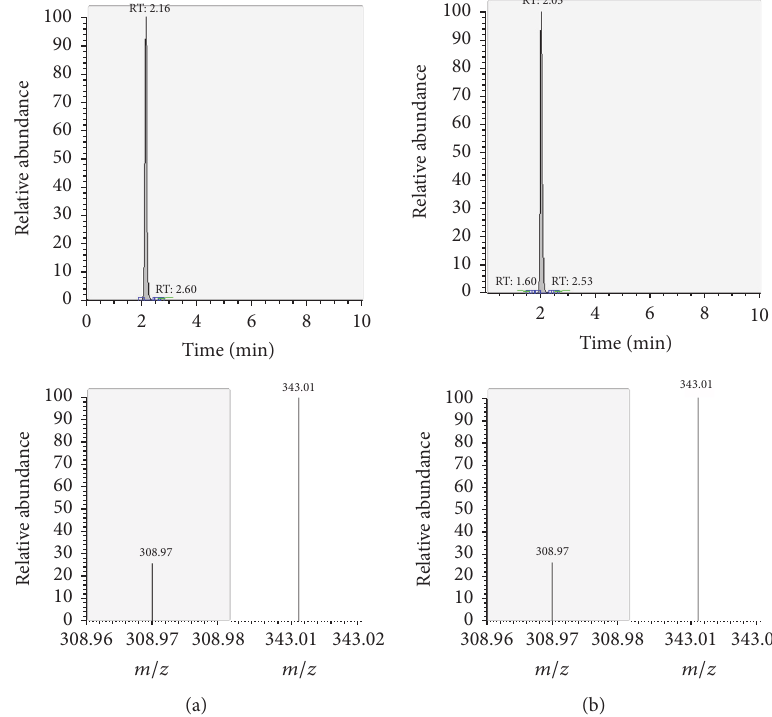
Figure 4: LC-MS/MS chromatograms of MPD and SRM transitions and relative abundances. (a) Standard in a 100 𝜇 g L −1 solution. (b) Standard in the spiked sample at 100mg kg −1 .